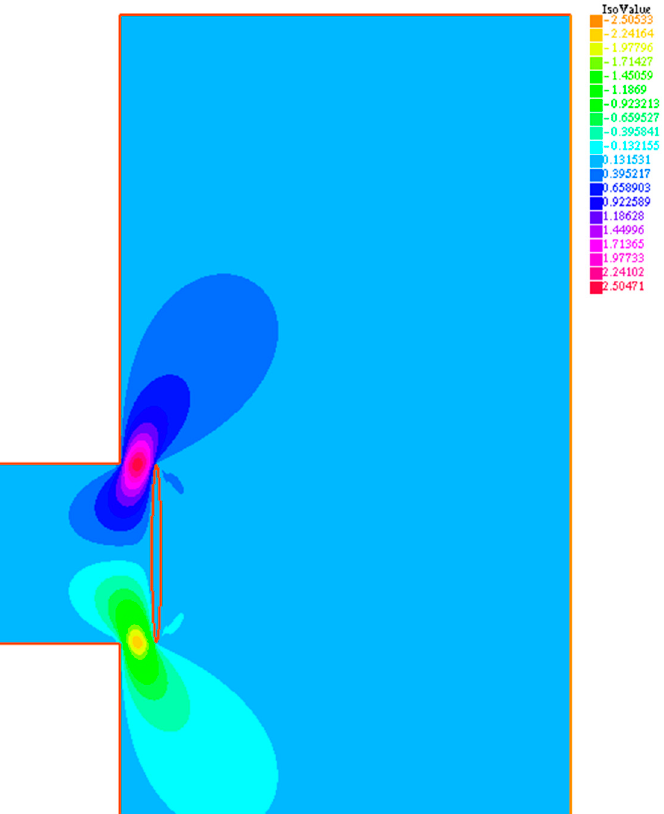
Figure 8. Case b: valve operative condition with h = 10 mm, with velocity vertical component v .